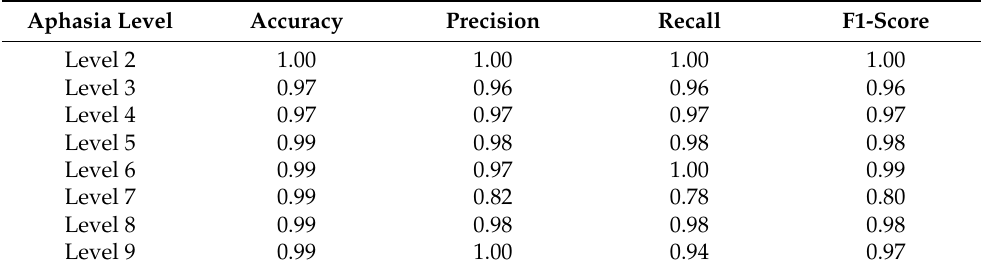
Table 17. Aphasia severity level classification report of random forest machine learning model using 10 s audio chunks whose features are extracted using MFCC.